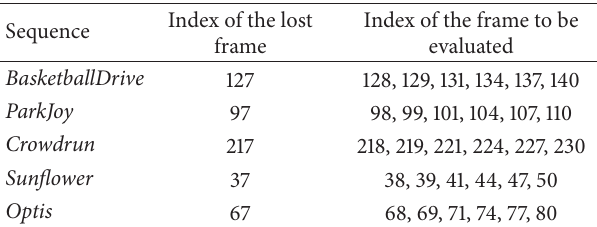
Table 2: Lost frame index of each